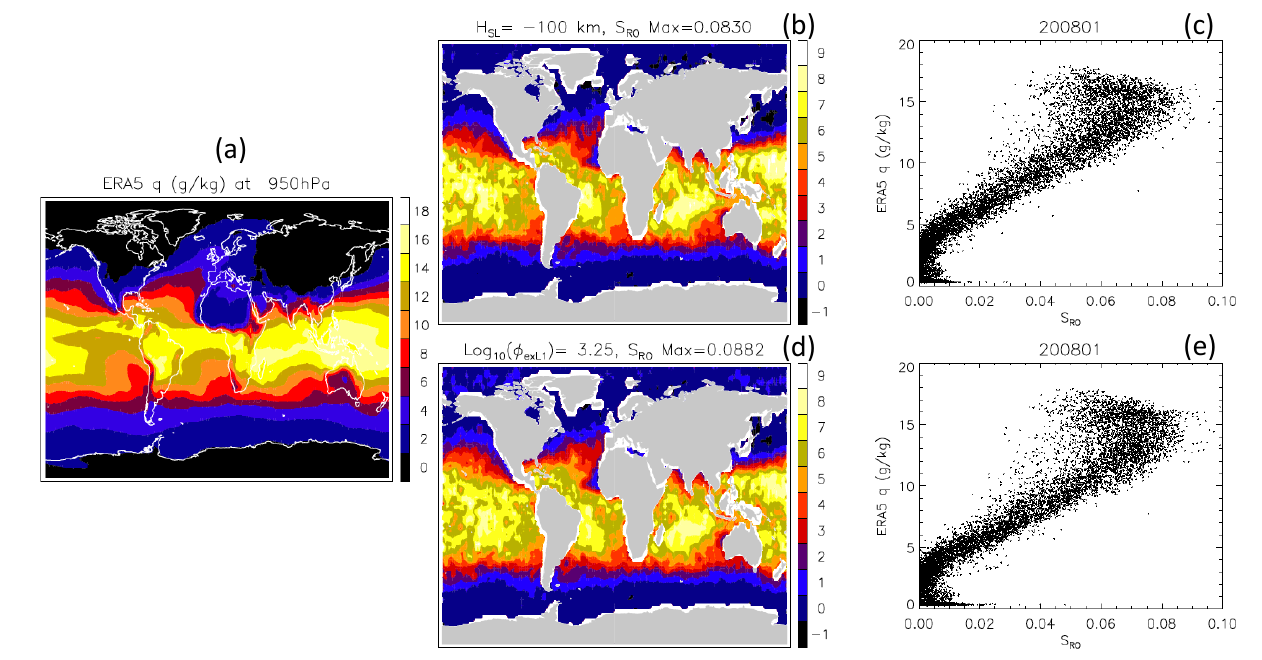
Figure 9. Correlation between monthly mean ERA5 q and COSMIC-1 S RO for January 2008: ( a ) ERA5 950-hPa q , ( b ) COSMIC-1 S RO at H SL = −100 km, ( c ) correction between ( a , b ), ( d ) COSMIC-1 S RO at Log 10 ( f exL1 ) = 3.25, and ( e ) correlation between ( a , d ). Both GNSS-RO and ERA5 data are on a 2 ◦ × 2 ◦ longitude–latitude grid. The color scales in ( b , d ) need to multiply the maximum value in the title to obtain the S RO values on the map. Surfaces with high (>100 m) elevation and large roughness (standard deviation > 30 m) are excluded in this comparison, which are masked in grey.